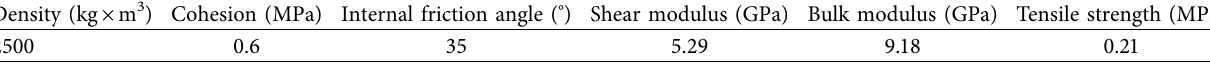
Table 1: Physical and mechanical parameters of